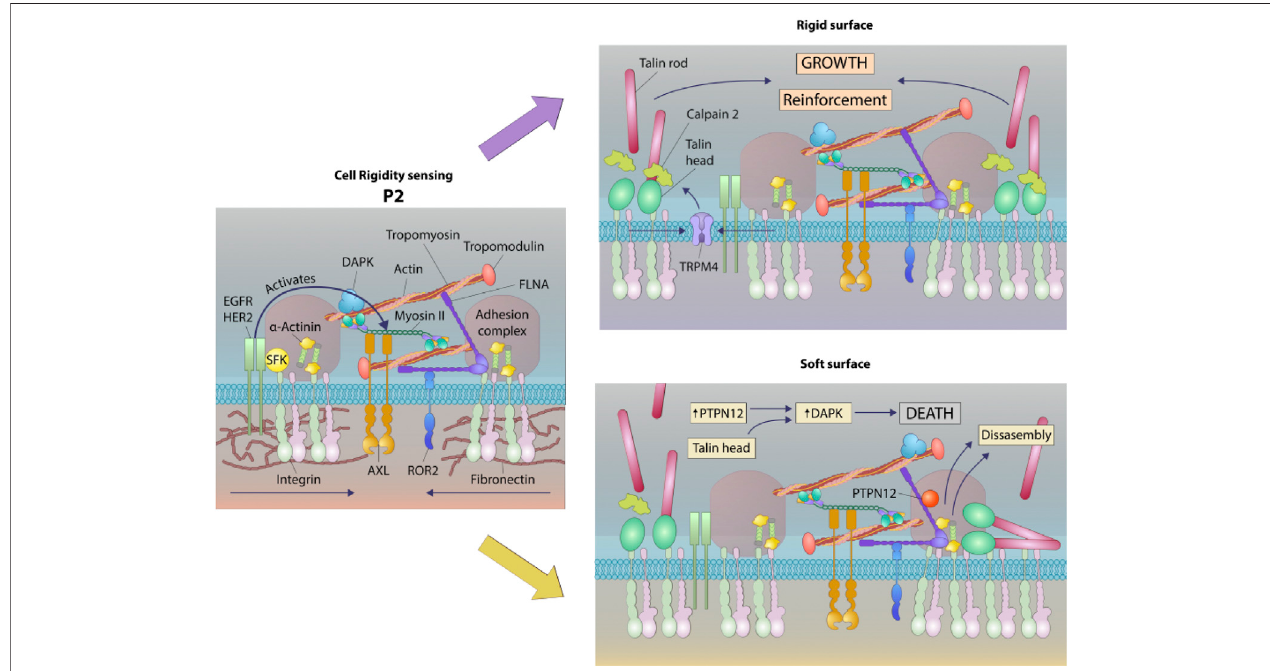
FIGURE8| SchematicofaworkingmodelofDAPK1shuttlingdependingonsubstraterigidity. Rigiditysensingmodulesformuponearlyinteractionwiththematrix (Wolfenson et al., 2019). Thesemodules include smallintegrin clusters that are connected at the intracellular side to actin fi bers. Myosin II mini- fi laments pull on the actin fi bersfromneighboringintegrinclusterstoaconstantdistanceof~100 nm,leadingtoproductionofdifferentforcelevelsbasedontheexternalrigidity.Highforcesonstiff matricesleadtoadhesionreinforcementthroughenhancedrecruitmentofproteinssuchas α -actinin,butonsoftsurfacestheforcesthataredevelopedarenothigh enough to induce reinforcement, leading eventually to adhesion disassembly (Wolfenson et al., 2016). These rigidity sensing modules are regulated at multiple levels, including by the receptor tyrosine kinases, AXL and ROR2, which regulatethe displacement level and its duration, respectively (Yang et al., 2016). EGFR and HER2 also regulatetheprocessbyactivatingitonrigidbutnotonsoftsurfacesdownstreamofSrcphosphorylation(Saxenaetal.,2017a).Thecurrentstudyaddstothismodelthe involvement of DAPK1, which has a dual role as a regulator of formation of mature adhesions on rigid matrices and in the activation of apoptosis on soft ones. In both cases, DAPK1 is recruited to the adhesions at early times through its interaction with Tpm1.1, that is, decorating the actin fi bers and through its interaction with the talin head domain. The reinforcement of adhesions that occurs on stiff matrices leads to DAPK1 stabilization in the adhesions. If the surface is soft, then the phosphatase PTPN12 dephosphorylates DAPK1, leading to its activation to induce apoptosis as the adhesions disassemble.